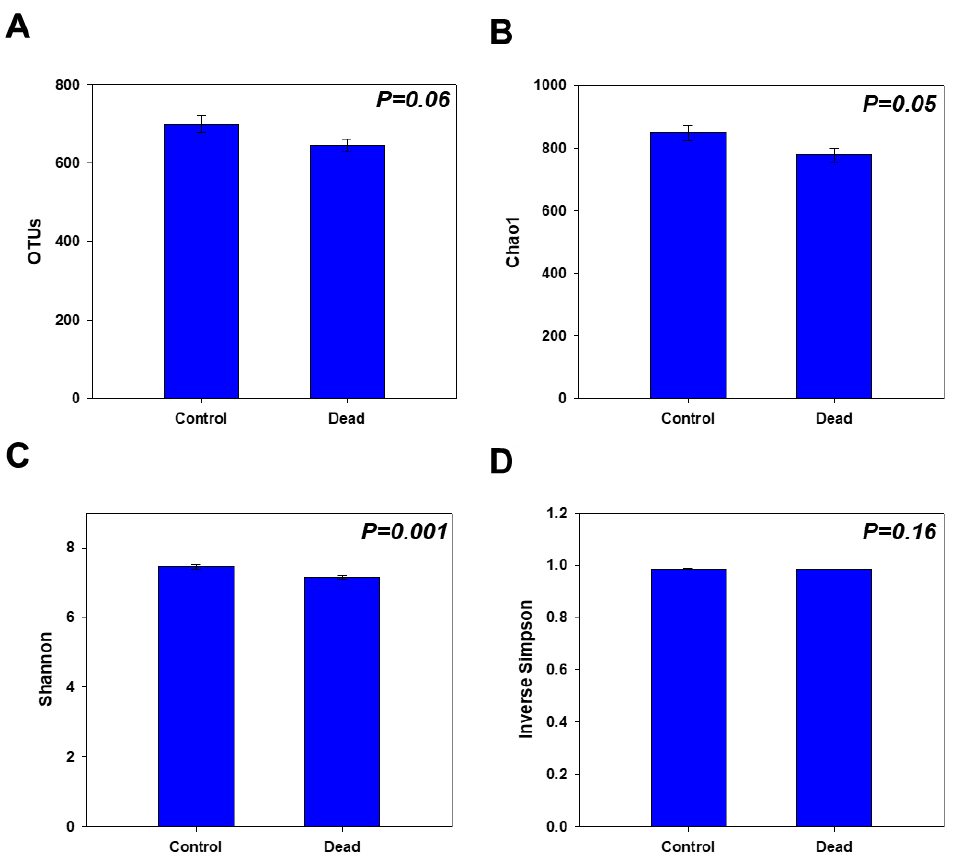
Figure 2. Bar graphs of the alpha diversity measures of the control healthy and standing dead Korean fir tree rhizosphere microbiomes. The graphs show the ( A ) number of operational taxonomic units (OTUs), ( B ) Chao1 indices, ( C ) Shannon diversity indices, and ( D ) inverse Simpson indices. Bars represent the means ± standard errors ( n = 15). The calculated p -values from Student’s t -test are shown on the graphs.